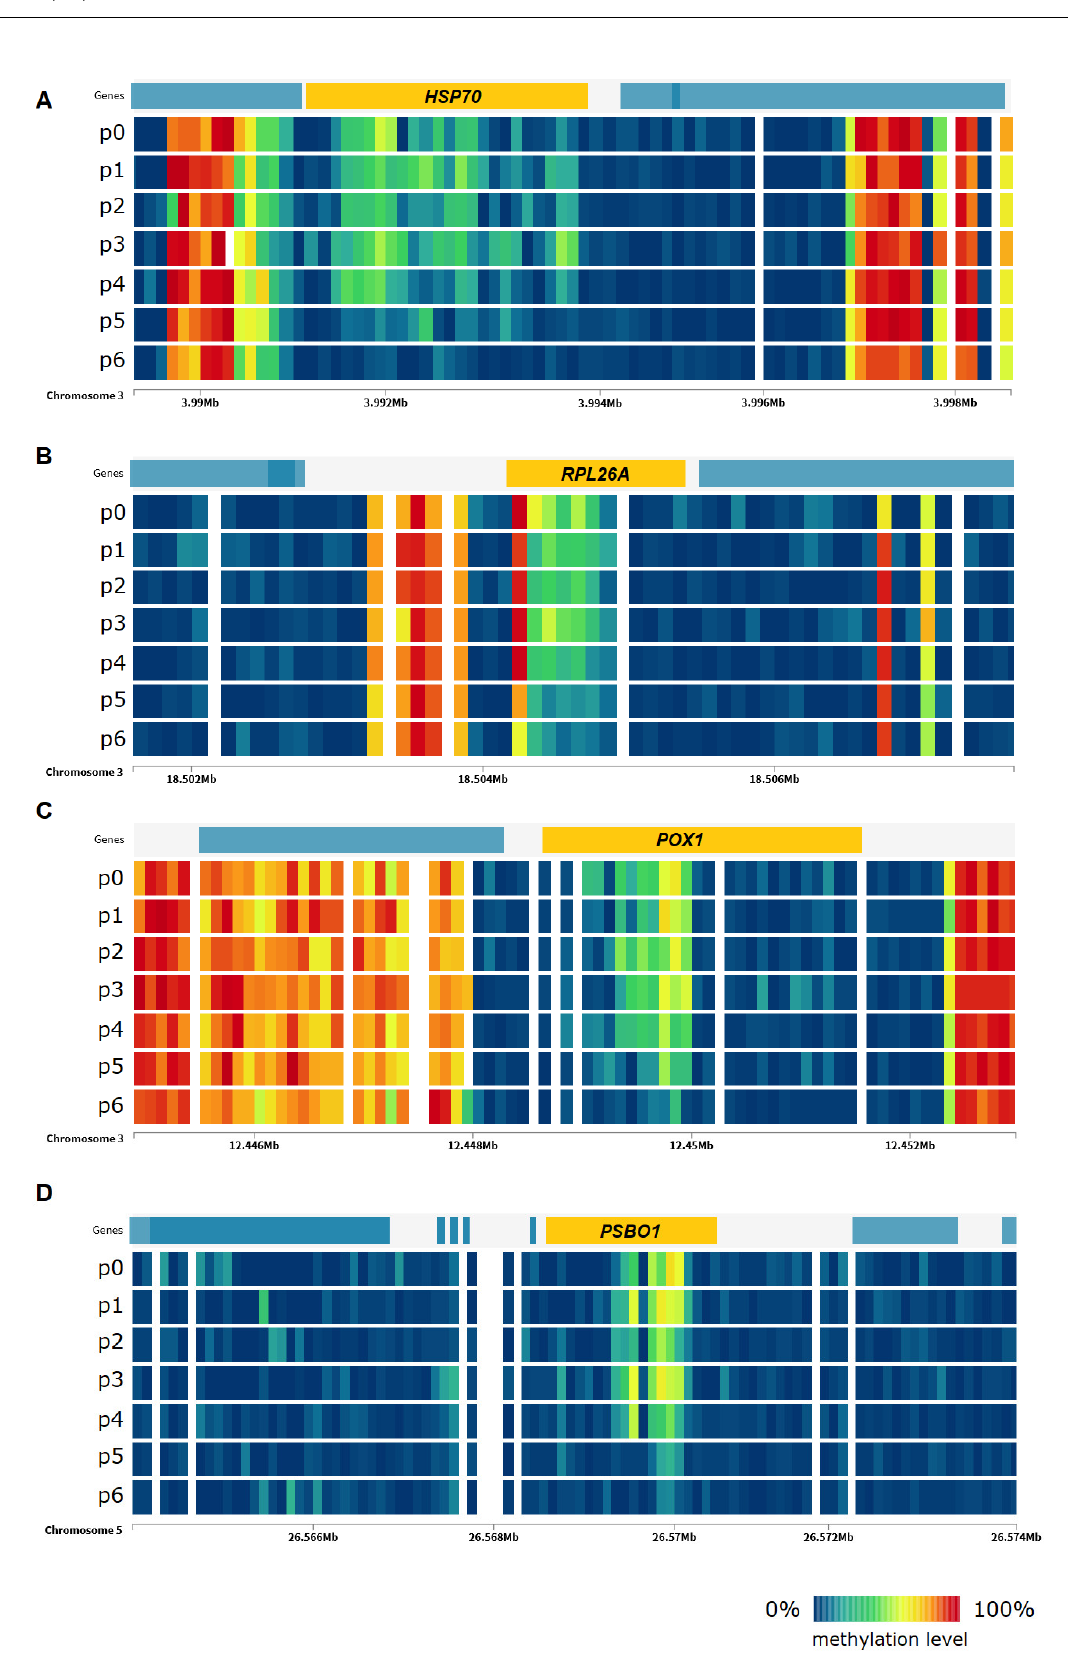
Figure 9. DNA methylation level in Arabidopsis thaliana genes (( A )— HSP70 , ( B )— RPL26A , ( C )— POX1 , ( D )— PSBO1 ) in CpG context under heat stress in the subsequent time points of the experiment.